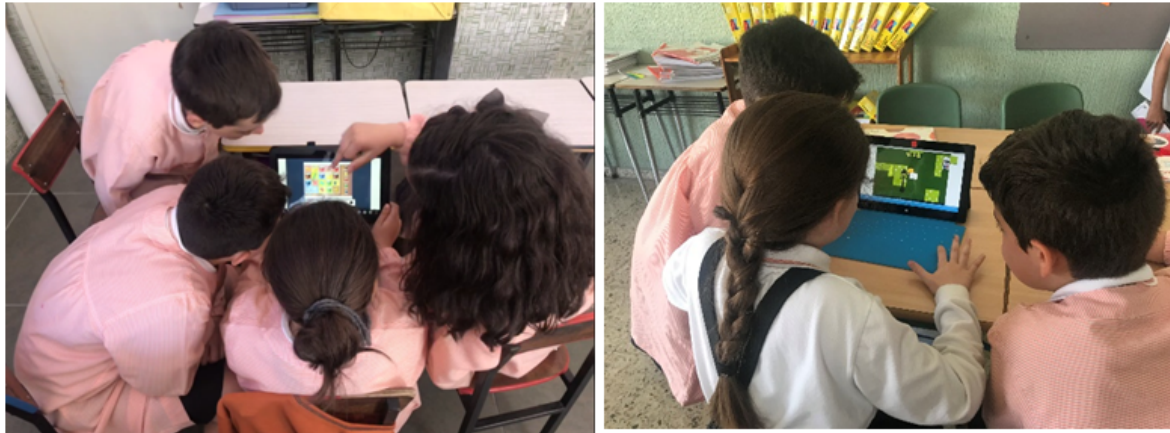
Figure 4. Children playing the online game “Los Cokitos”.